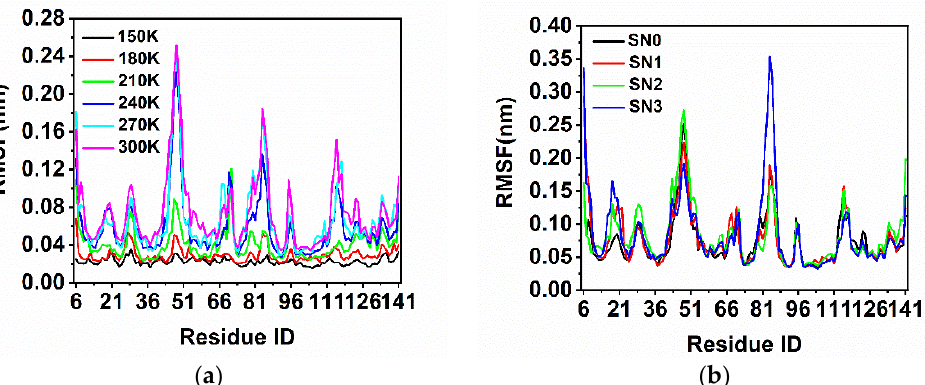
Figure 2. The changes in RMSF of residues in each system: ( a ) changes in RMSF of SN0 at different temperatures; ( b ) changes in RMSF under different mutation conditions at 300K.